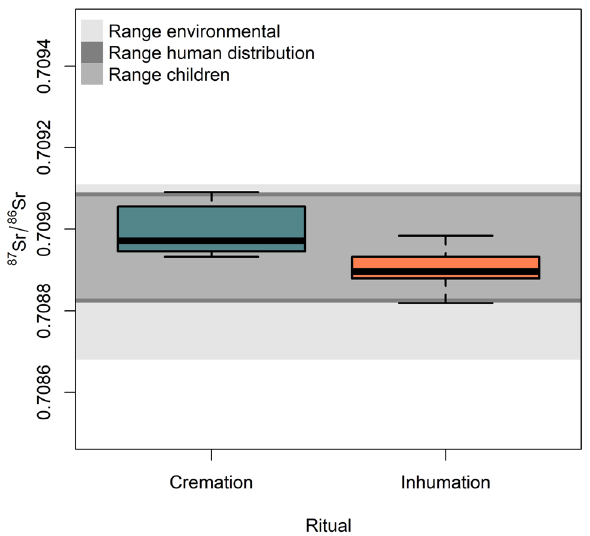
Figure 4. Box–and–whiskers plot of 87 Sr/ 86 Sr range for cremations (petrous bone and tooth enamel) and inhumations (tooth enamel) at Fermo with the three baseline ranges (i.e., environmental samples, human distribution, children range) in grey, considering only individuals that fell within the three